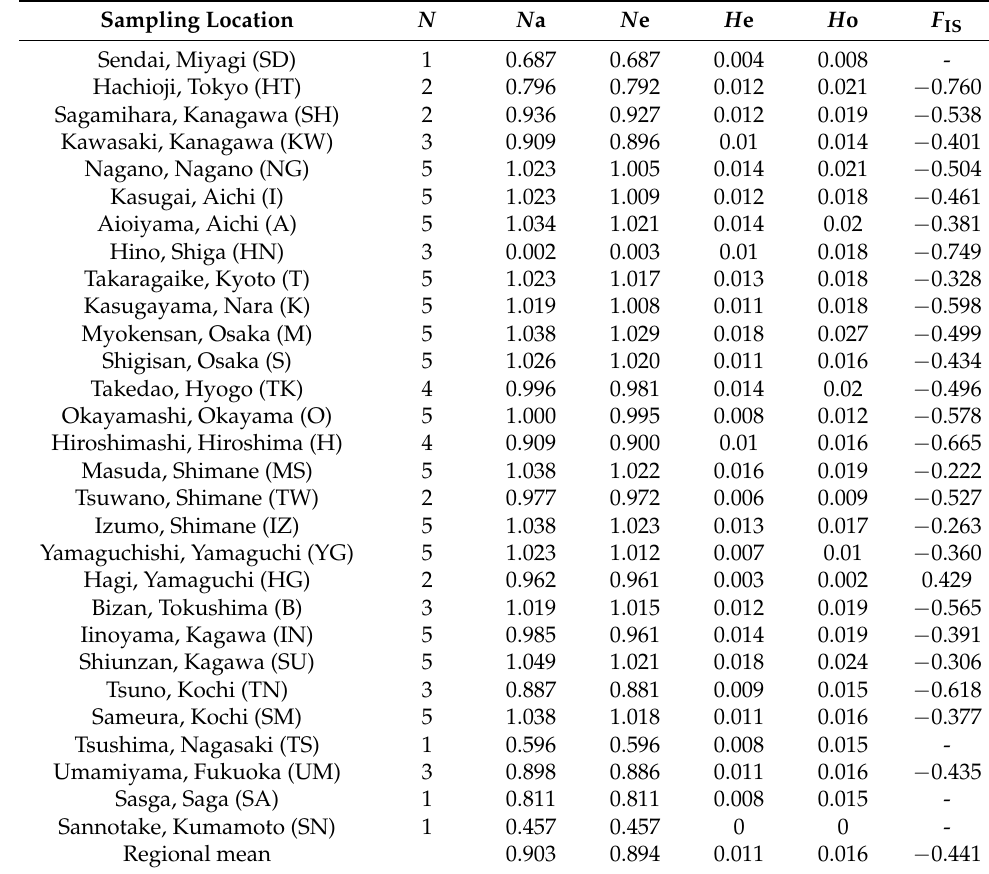
Table 1. Genetic diversity parameters of the 29 populations of Lindera glauca (Lauraceae) in Japan based on 246 single nucleotide polymorphism (SNP) loci. Letters in parentheses are abbreviations of sampling